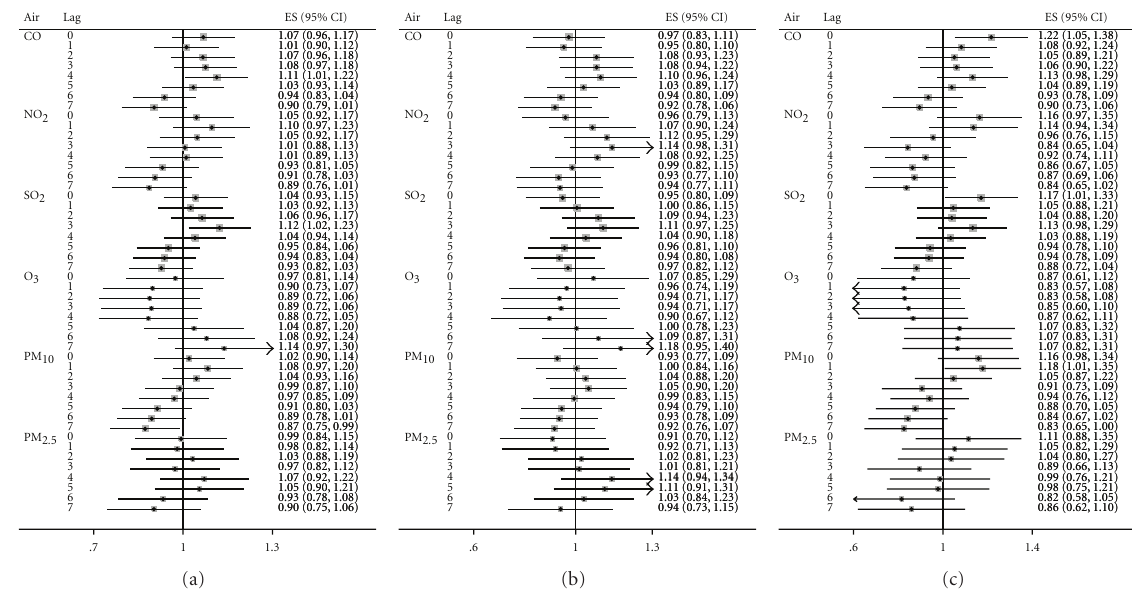
Figure 1: Odds ratios for ED visits for stroke associated with exposure to air